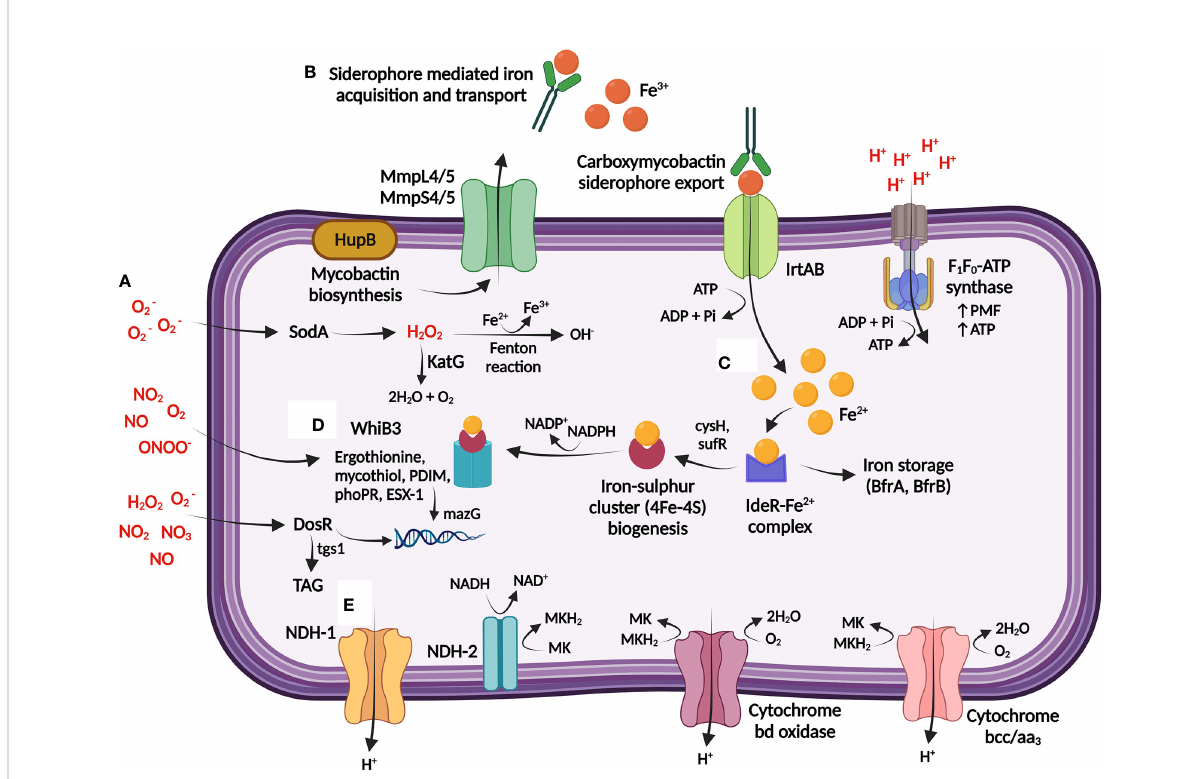
FIGURE 2 M. tuberculosis maintains bioenergetic metabolism to ensure redox homeostasis during persistence. (A) The host generates toxic reactive oxygen species (ROS) and reactive nitrogen species (RNS) [shown in red] through single-electron reactions, which can result in damage to M. tuberculosis DNA and proteins. (B) Redox homeostasis is maintained through the sensing and regulation of iron, obtained from the host via Fe 3+ -speci fi c iron scavenging siderophores that is imported into M. tuberculosis by the ABC exporter, IrtAB. (C) Iron is either stored or utilized directly for generation of iron sulphur clusters (4Fe-4S), and further encoded to 4Fe-4S redox sensor proteins by WhiB3. (D) WhiB3 produces detoxi fi cation buffers (ergothionine and mycothiol) and in combination with DosR directs the reducing equivalents produced during b -oxidation of fatty acids to produce cell wall lipids and protect DNA from oxidation. DosR further regulates lipid storage within M. tuberculosis through the regulation of TAG, providing a lipid rich nutrient source. (E) Proton balance during redox homeostasis is maintained through regulation of internal protons which can be utilised for the production of menaquinol (MKH 2 ) [via NDH-1/NDH-2], which is subsequently transferred to the respiratory complexes (cytochrome bd and cytochrome bcc/aa 3 ) to maintain the PMF and ATP production via F 1 F 0 -ATP synthase. TAG: triacylglycerol; MK: Menaquinone; NDH: NADH dehydrogenase; Fe 3+ : ferric ion; Fe 2+ : ferrous ion; O − 2 : superoxide; NO: nitric oxide; NO 2 : nitrogen dioxide; ONOO - : peroxynitrite; H 2 O 2 : hydrogen peroxide; MmpL: mycobacterial membrane protein large; MmpS: mycobacterial membrane protein small. Created with